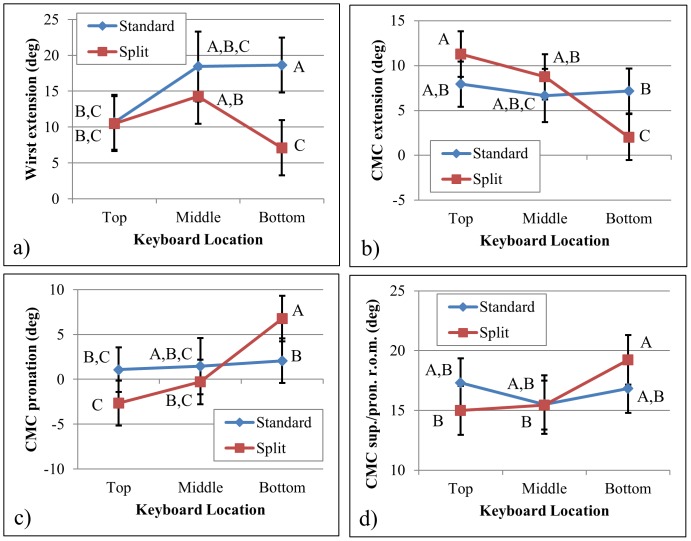
Significant interaction effects between Keyboard Location and Keyboard Layout.Least squares (and standard error) values are presented for (a) mean median wrist extension across keyboard location and keyboard layout, (b) median CMC extension across keyboard location and keyboard layout, (c) median CMC pronation across keyboard location and keyboard layout, and (d) CMC joint range of motion for the sup./pron. axis across keyboard location and keyboard layout. The superscript letters in the figure represent results from the Tukey post-hoc analysis: same letters denote groups without significant differences. Values with different letters are ranked such that A>B>C.